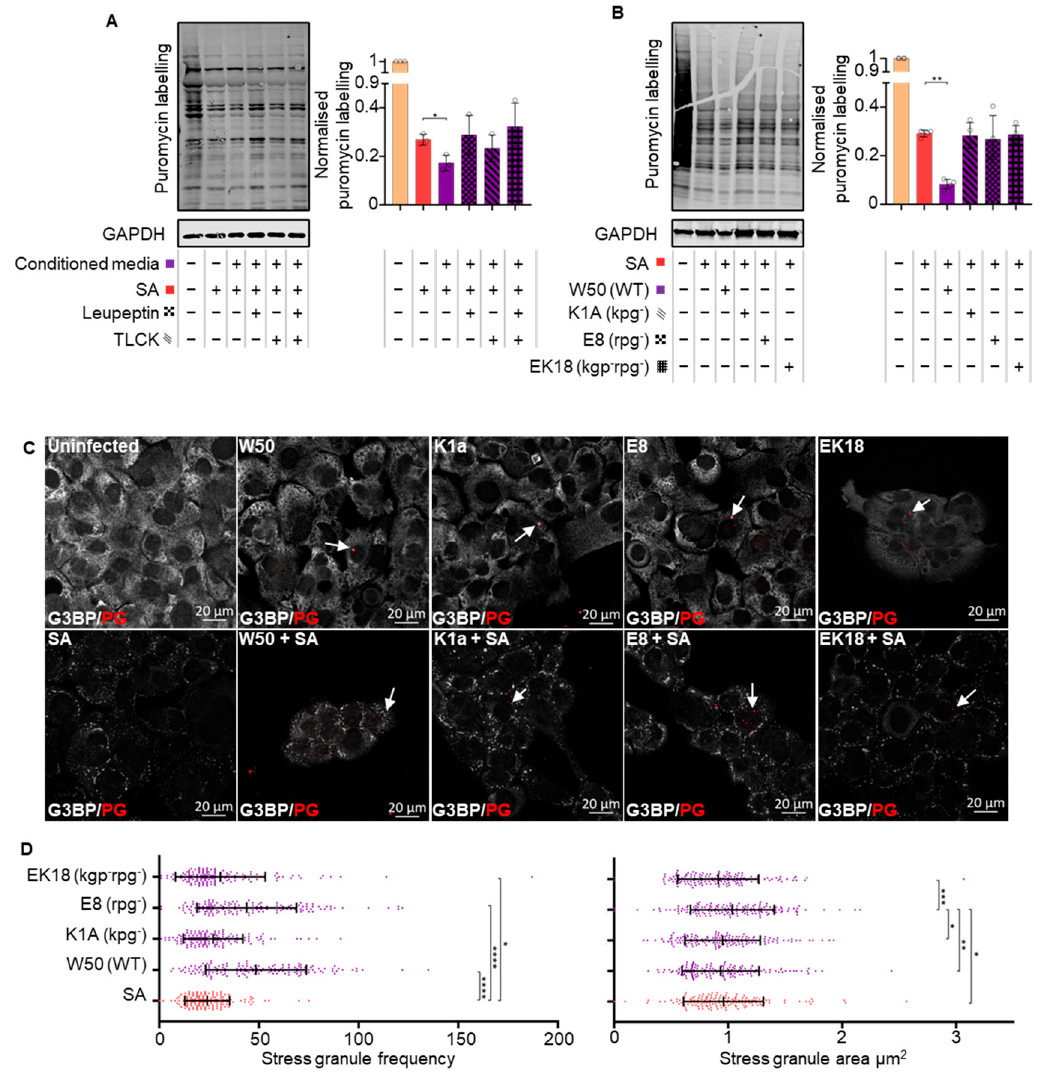
Figure 6. Secreted P. gingivalis proteases and gingipains mediate heightened translational repression during infection and stress. ( A ) Relative rate of protein synthesis as determined by puromycin uptake (left) and concentration relative to GAPDH (right) when H357 cells were treated with P. gingivalis (NCTC11834)-conditioned media in the presence or absence of leupeptin and TLCK and (mean ± SD, n = 3) ( B ) with P. gingivalis (W50, K1A ( kgp − ), E8 ( rgp − ), and EK18 ( rgp − kgp − ), MOI of 100, t = 2 h); (mean ± SD, n = 4). ( C ) Stress granule formation was assessed by visualization of G3BP1 (white) and P. gingivalis (red) by confocal microscopy using Z-stacks. ( D ) Average area and frequency of SGs found in cells ( n = 3, 50 cells per biological replicate). **** p ≤ 0.001; ***, p ≤ 0.001; **, p ≤ 0.01; *, p ≤ 0.05 according to Kruskal–Wallis with Conover–Inman post-hoc.